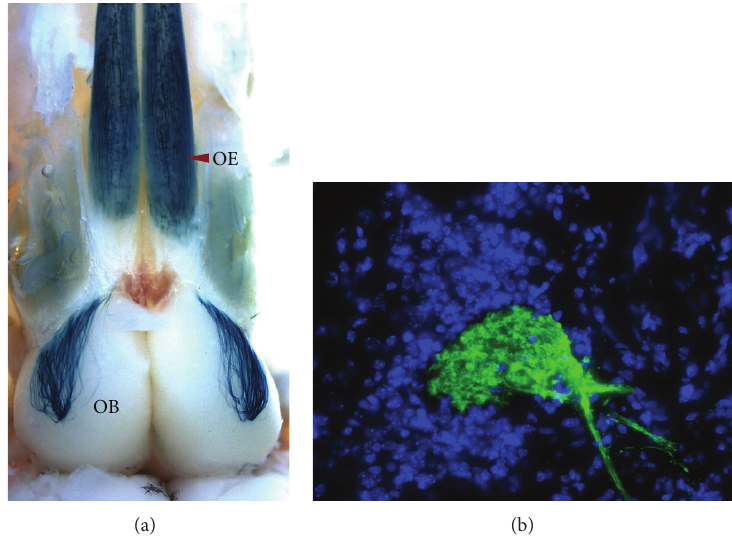
Figure 4: OSN in the OE that expresses the same type of OR projects axons to specific coordinates in the OB forming glomeruli. (a) The OB and the OE of a M72tLacZ mouse are shown (dorsal view). Neurons and axons that contain beta-galactosidase activity (blue) are revealed by X-gal. The M72 neurons, scattered throughout the OE, project their axons to the dorsal-posterior part of the OB and form at least one glomerulus. (b) OB coronal slice (20 𝜇 m) of a M72tGFP mouse. The M72 glomerus, surrounded by periglomerular cells (stained with DAPI, blue), only contains axons (green) from the M72 OSN